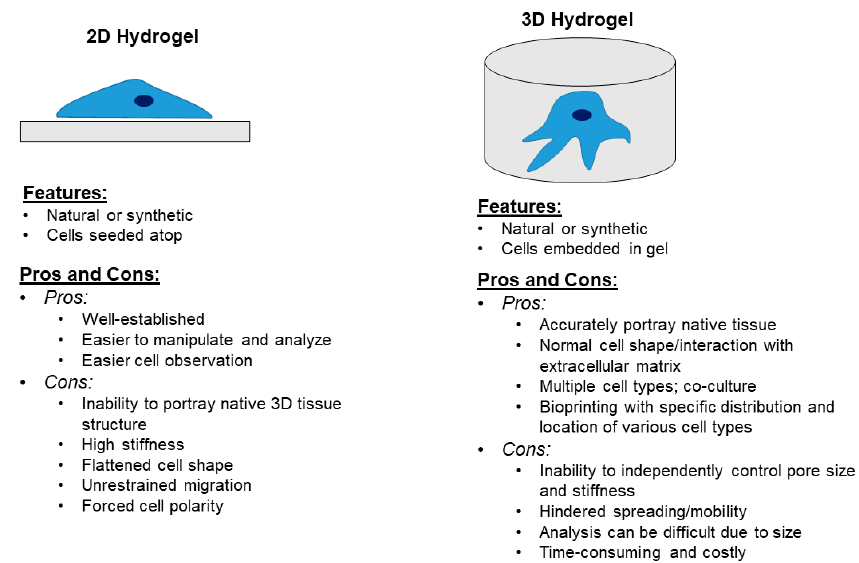
Figure 6. Hydrogels as models of the bone matrix. Hydrogels are unique model systems that can be used to determine interactions between cells and the bone matrix. This image shows cellular comparisons between 2D and 3D hydrogels. Cells are cultured atop a 2D hydrogel coated with a matrix, such as collagen, whereas cells are embedded in 3D hydrogels.